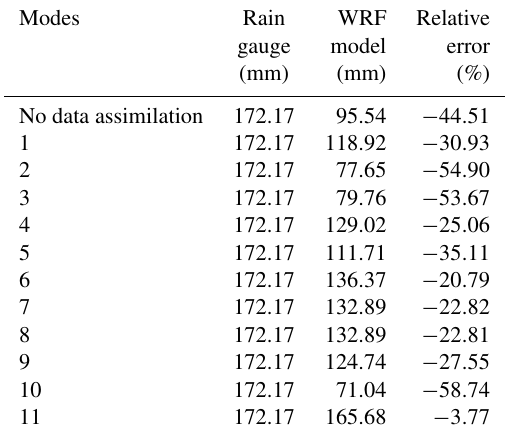
Table 3. Observed and forecasted 24h accumulated areal rainfall from different data assimilation